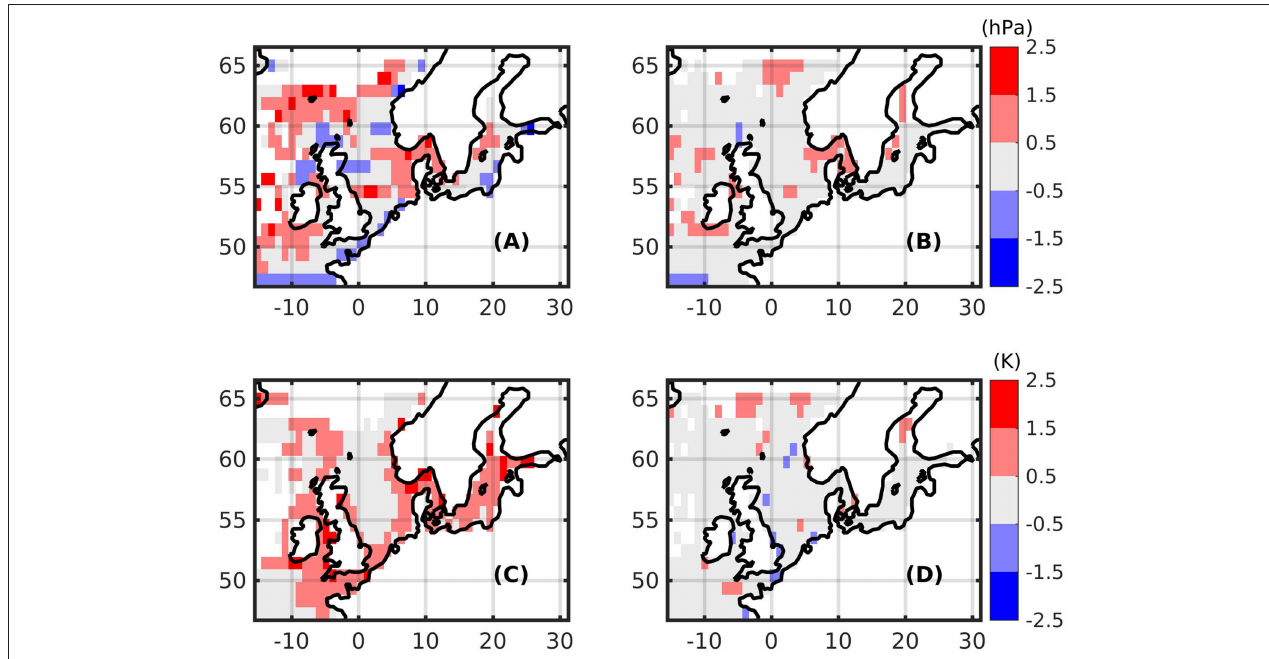
FIGURE 5 | Difference between BNSC and ERA Interim Climatology 1981–2010 for mean sea level pressure (A,B) and air temperature (C,D) for the months January (A,C) and July (B,D) .